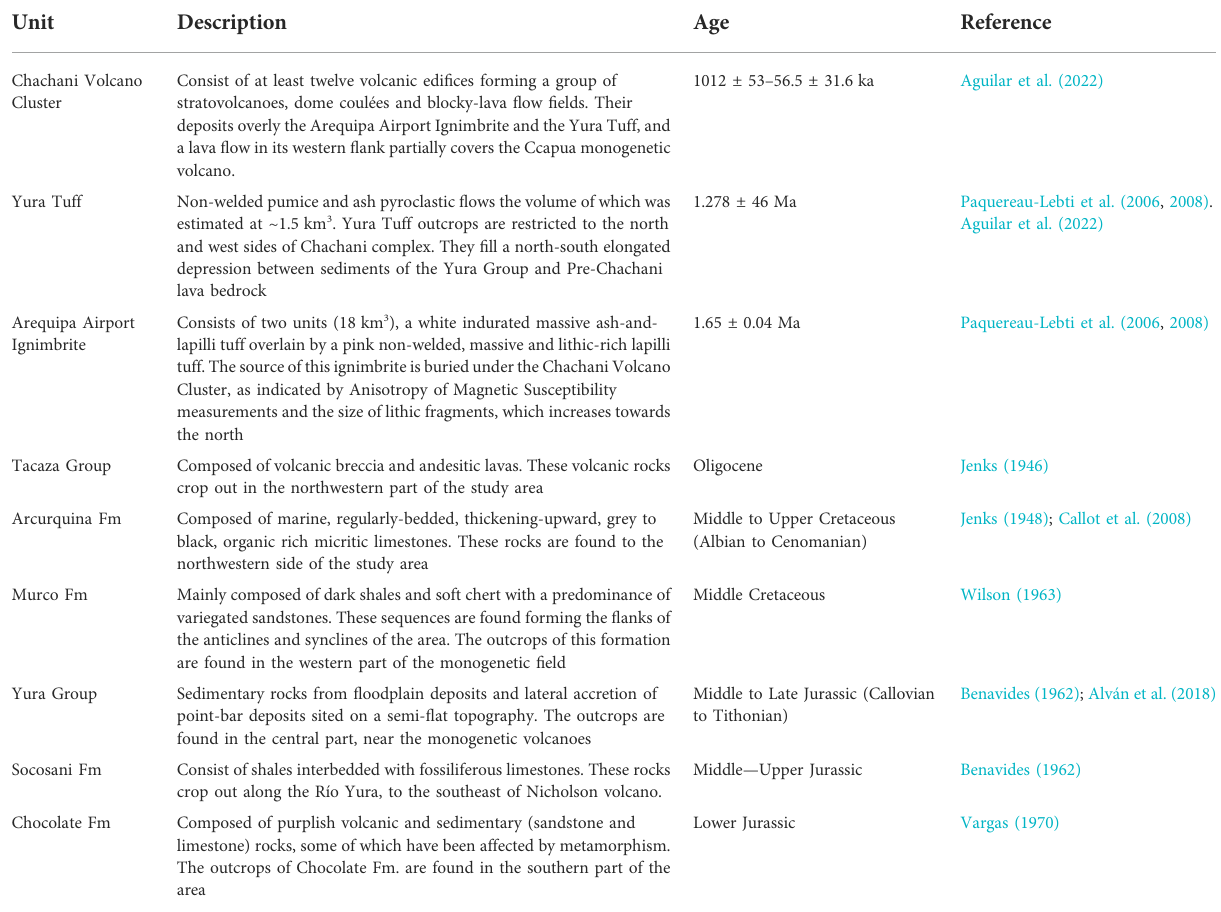
TABLE 1 Bedrock in the surrounding areas of the Yura Monogenetic